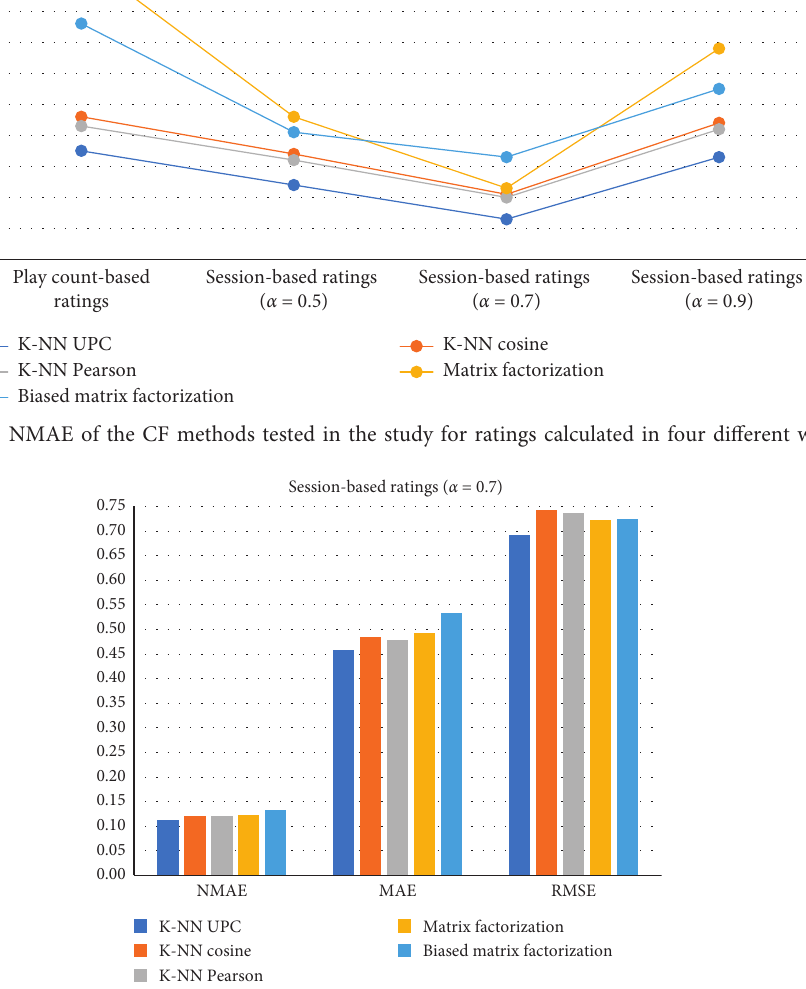
Figure 6: Comparison of the methods tested in the study with session-based ratings ( α �